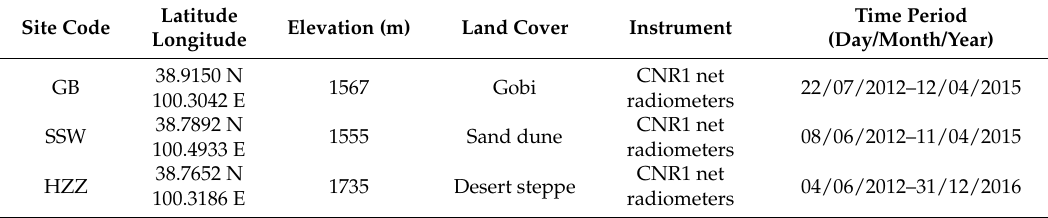
Figure 1. Spatial distribution of the three ground sites. The background is an Advanced Spaceborne Thermal Emission Reflection Radiometer (ASTER) false-color visible near-infrared (VNIR) image captured on 3 September 2012. Table 1. Descriptions of the three study sites.